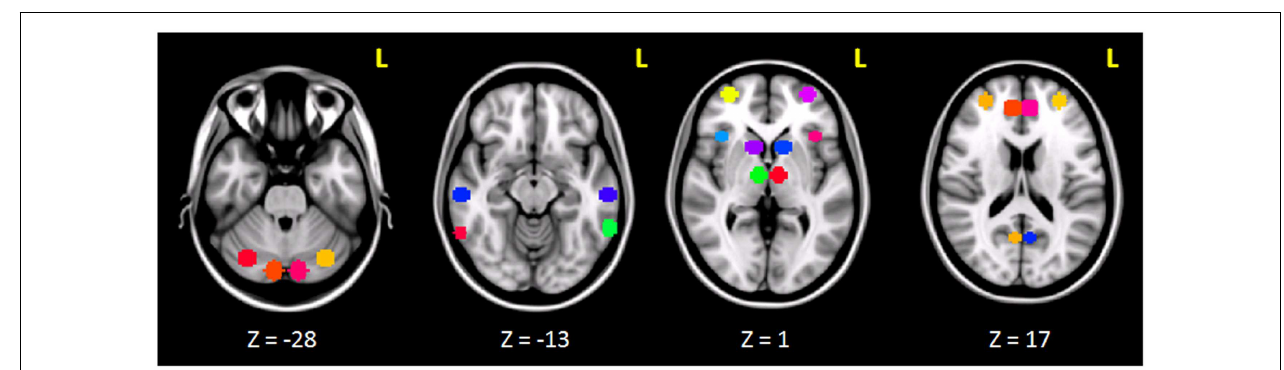
FIGURE 3 | Spherical ROIs (radius = 8mm) defining the nodes of the network investigated before and after cTBS .